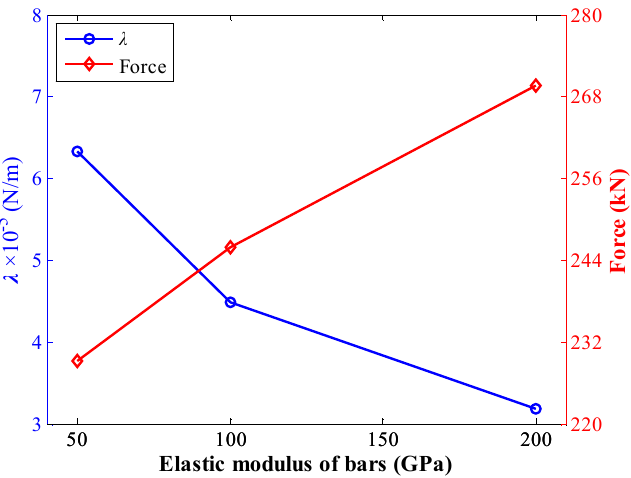
Figure 7. Relationship between the maximum force of the bars, λ , and the elastic modulus of the bars.